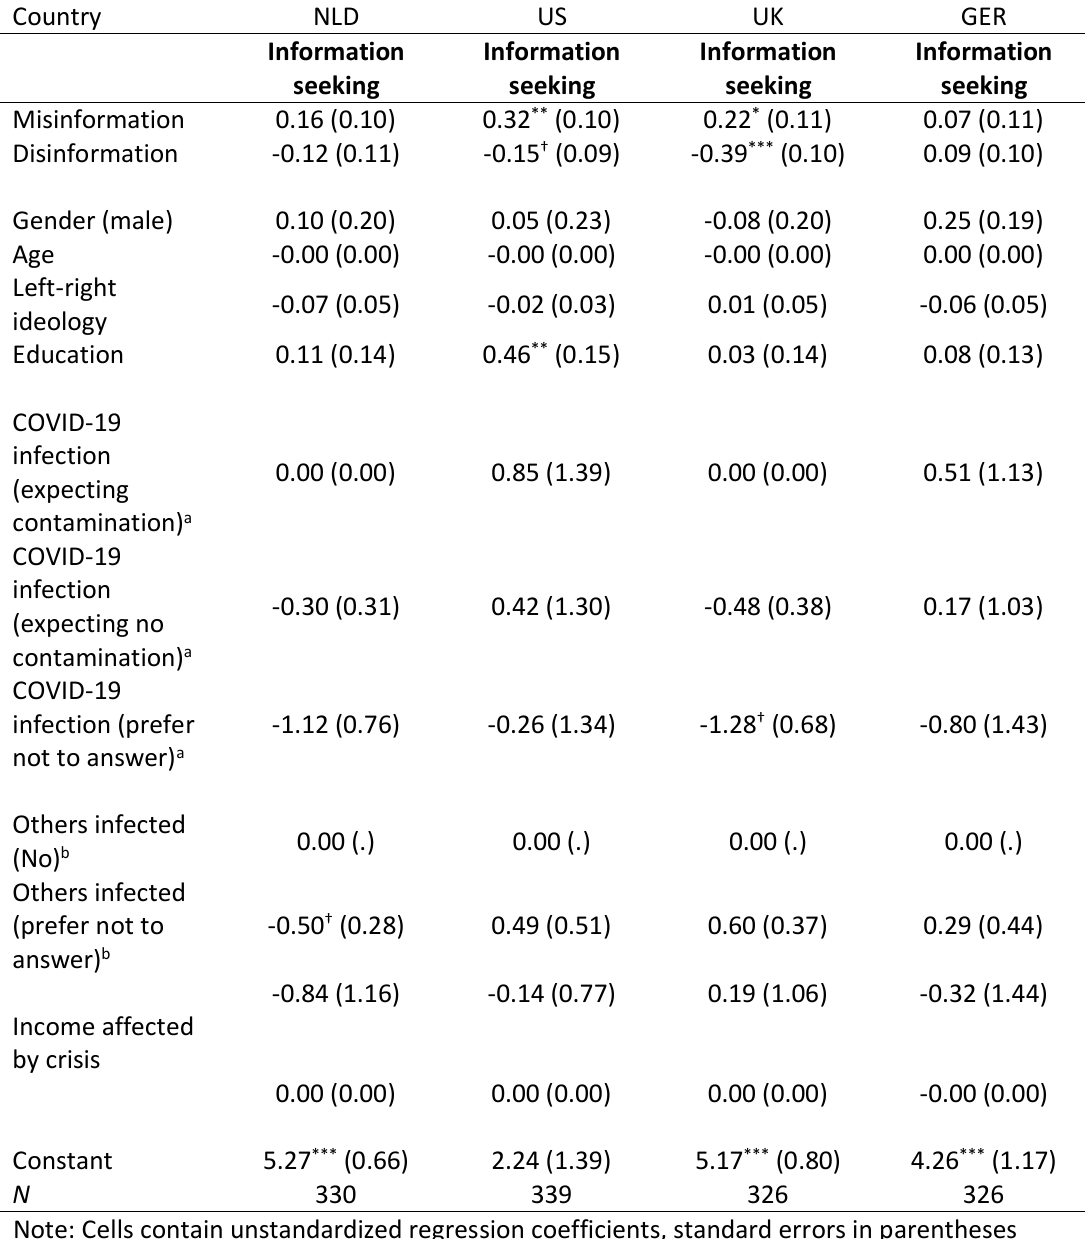
Table B3 . Information seeking predicted by levels of perceived mis- and disinformation, specified per